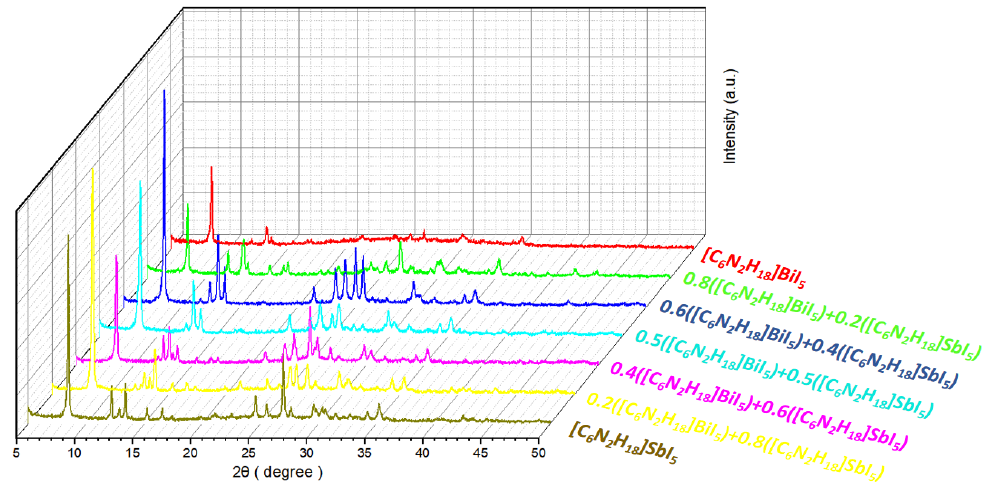
Figure 2. X-ray diffraction spectra of ferroelectric materials with different mixing ratios.